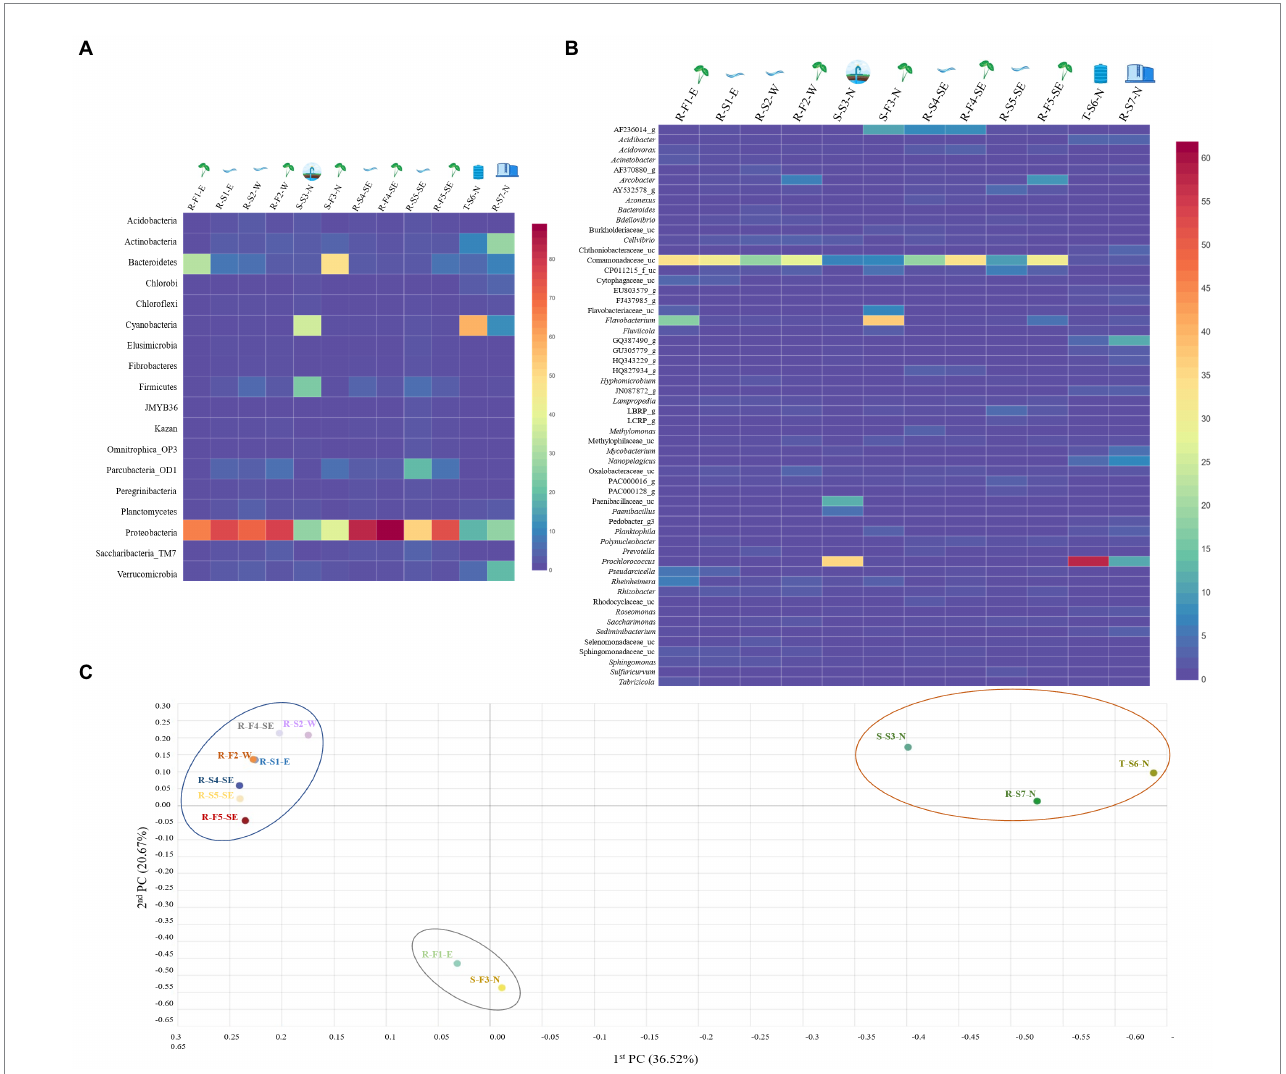
FIGURE 1 The distribution heatmap of bacterial (A) phylum and (B) genus detected with relative abundance > 1% among all the water samples sequenced using Illumina iSeq100, an amplicon sequencing platform and analyzed on EzBioCloud. The heatmap was generated using displayR. (C) Principal Coordinate Analysis (PCoA) clustering based on Bray–Curtis dissimilarity index was analyzed at genus level bacterial structure to visualize the variation in bacterial community structures among 12 different samples, forming three distinctive clusters. Cluster 1 (blue circle) shows close microbial communities of river streams and associated field samples, irrespective of geographical location. Cluster 2 (red circle) represents close microbial association between samples collected from North Oahu. Cluster 3 (gray circle) shows close microbial association between sample R-F1-E and